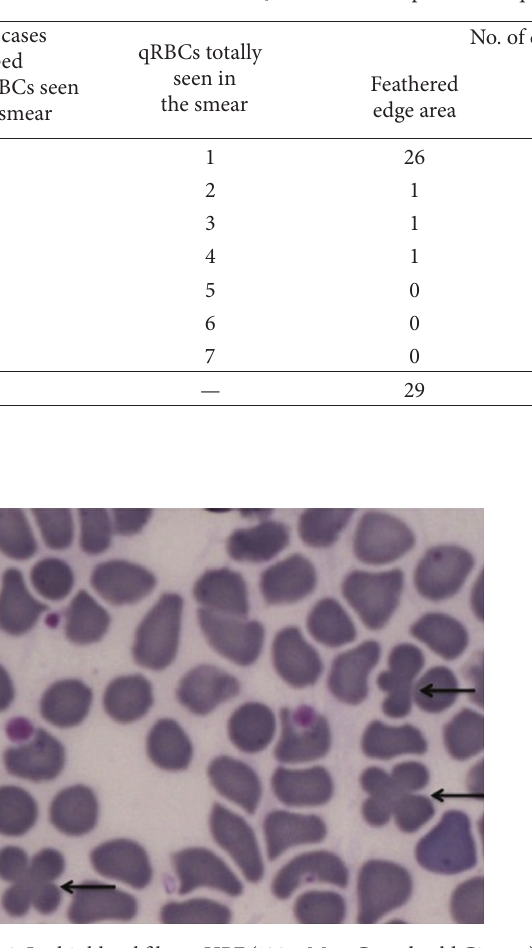
Figure 3: In this blood film at HPF (100x, May-Grundwald Giemsa) three qRBCs (black arrows) can be easily seen.